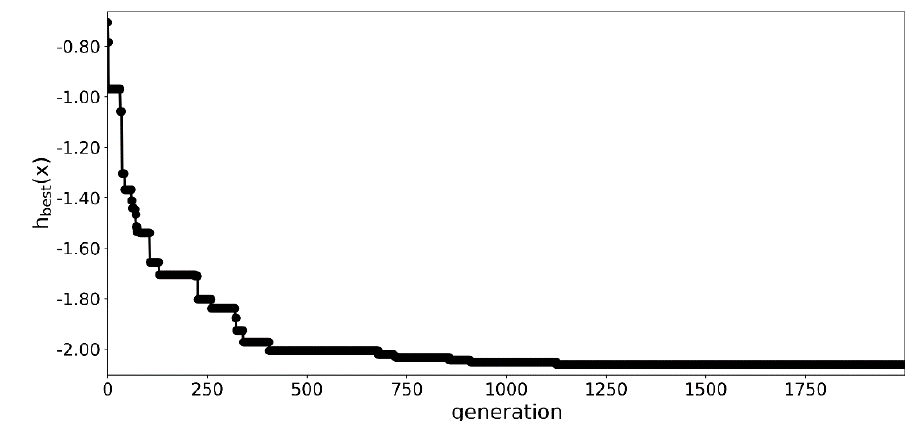
Figure 5. Value of the best fit specimen over the 2000 generations.